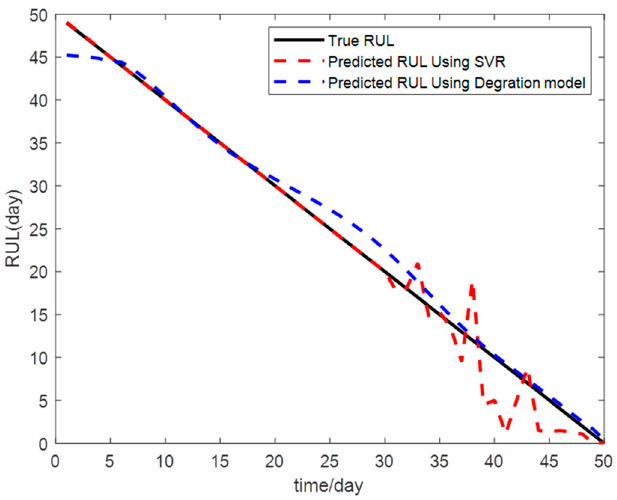
Figure 9. Degradation trajectory of HSSB and prediction trajectory of the exponential degradation model.